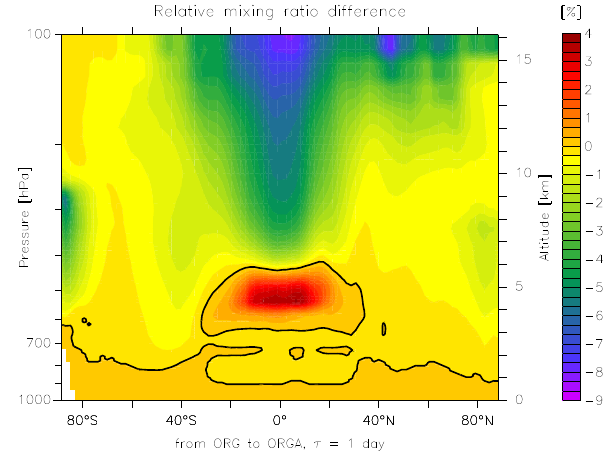
Figure 3. Relative difference in zonally and 2001 averaged mixing ratios for ORGA compared to ORG. Results are shown for the tracer with a lifetime of 1